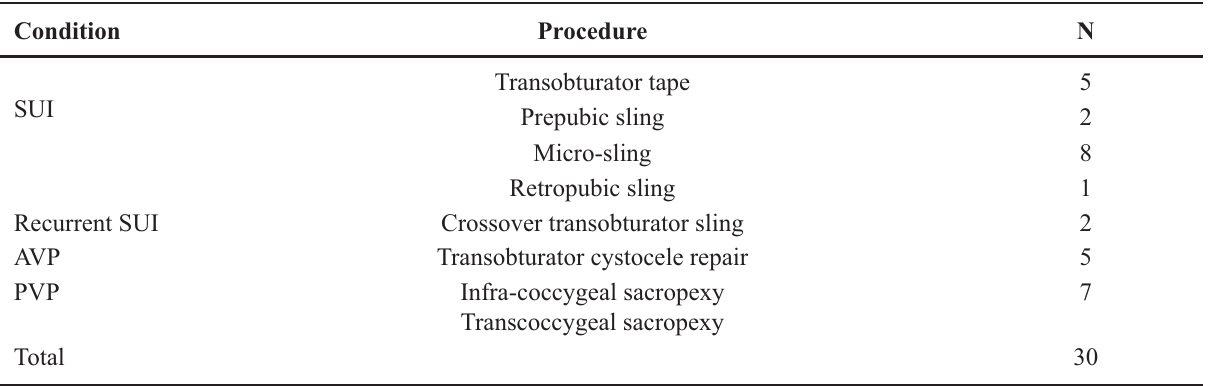
Table 1 – Demographic data from patients and